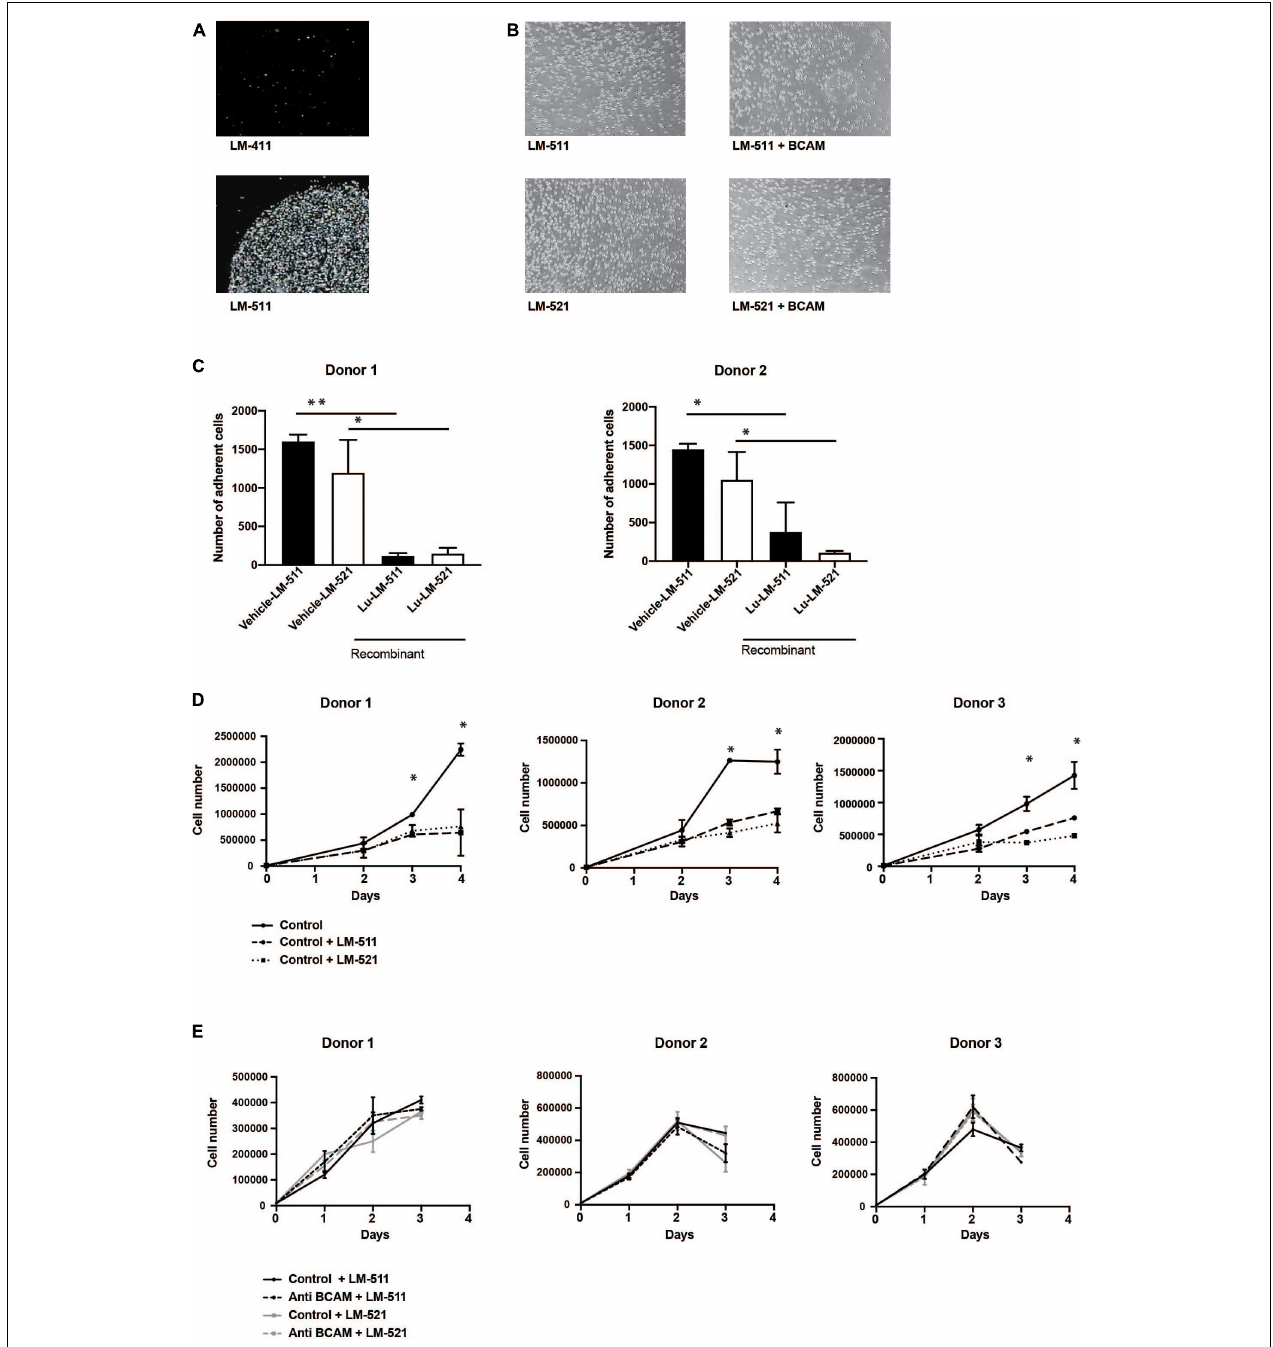
FIGURE 5 | Anti-BCAM/Lu antibodies do not inhibit CD34 + HSPC attachment to LM-511 and LM-521 nor do enhance CD34 + HSPC proliferation in presence of LM-511 and LM-521. (A) Cell-matrix adhesion assays were performed with MACS-sorted CD34 + HSPC with LM-411 and LM-511, laminins which were immobilized on the plastic dish. Cell adhesion could only be observed to LM-511, but not to LM-411. (B) CD34 + HSPC were allowed to adhere to LM-511, LM-521 in the presence of anti-BCAM/Lu antibodies and without antibodies (control). Representative image of three independent experiments. (C) Cell-matrix adhesion assays were performed with MACS-sorted CD34 + HSPC with LM-511 and LM-521, in presence of vehicle and recombinant BCAM/Lu protein. Cell adhesion to LM-511 and LM-521 could be inhibited by recombinant BCAM/Lu protein. (D) MACS-sorted CD34+ cells from three donors incubated in serum-free expansion medium with 10 µ g/ml LM-511 and LM-521 or without (control) were cultured for three consecutive days. Cells were harvested each day, and the proliferation rate was determined. LM 511 and LM 521 drastically diminished CD34+ cell proliferation. (E) Antibodies against BCAM/Lu did not interfere with CD34 + cell proliferation which were cultured for 3 days in serum-free expansion medium in the presence of 10 µ g/ml anti-BCAM/Lu antibodies and LM-511 or LM-521. The control without laminin isoforms is not shown in these diagrams. * p < 0.05; ** p < 0.005.